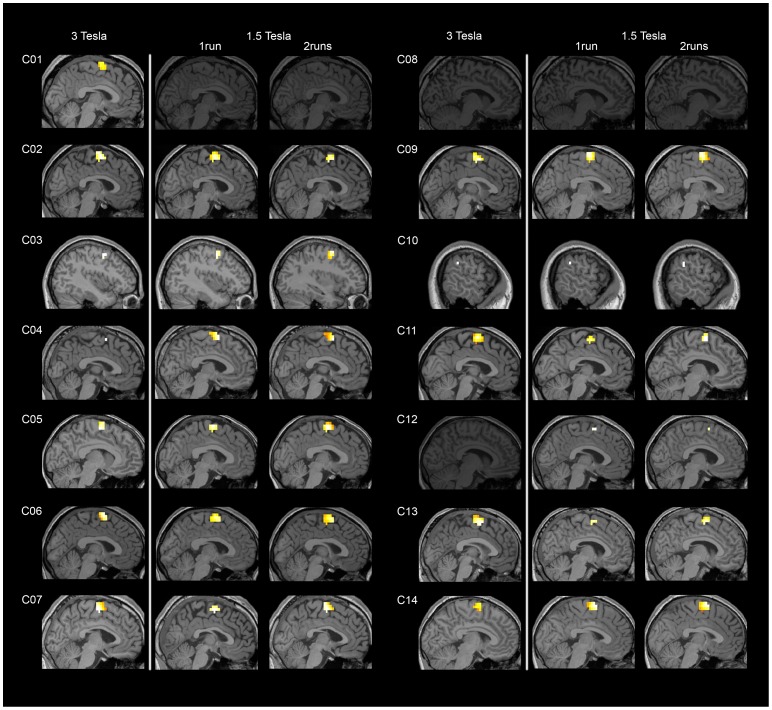
Example of individual results for the motor imagery task versus rest.For each subject, the ROI showing highest consistency across scanning sessions is displayed. All participants, except C03, C08 and C10, showed activation of SMA in at least one scanning session. Participants C03 and C10 activated other anatomically appropriate areas (dorsal premotor cortex and inferior parietal lobule respectively). Participant C08 failed to show any significant activation for any scanning session. Participant C01 failed to show any significant activation in the scanning session at 1.5T while participant C12 failed to do so at 3T. Results are thresholded at a FWE-corrected p<0.05.